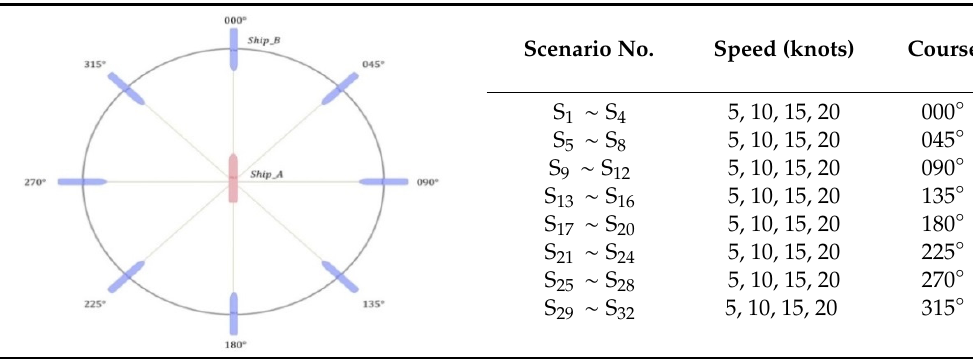
Table 3. Overview of simulation